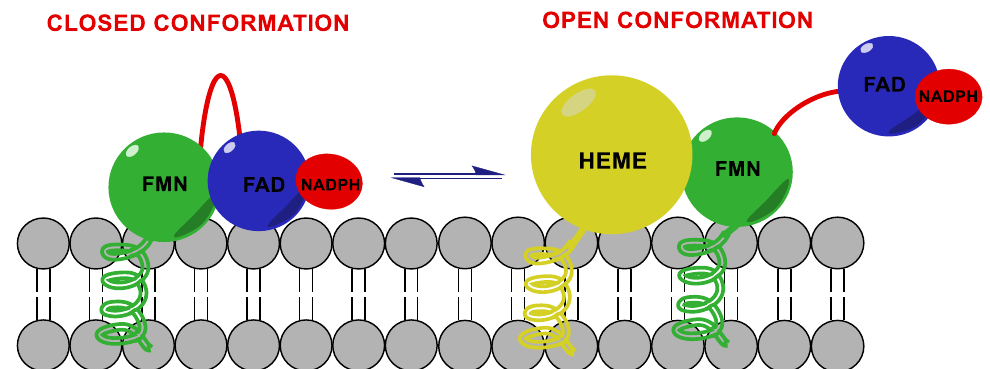
Figure 3. Aromatase complex. Flavin adenine dinucleotide (FAD) and flavin mononucleotide (FMN) domains of NADPH-cytochrome P450 reductase (CPR) can take a “closed” conformation, favoring the internal transfer of electrons, or an “open” conformation, where the two cofactor domains are far away, allowing the transfer of electrons from FMN to monooxygenase.